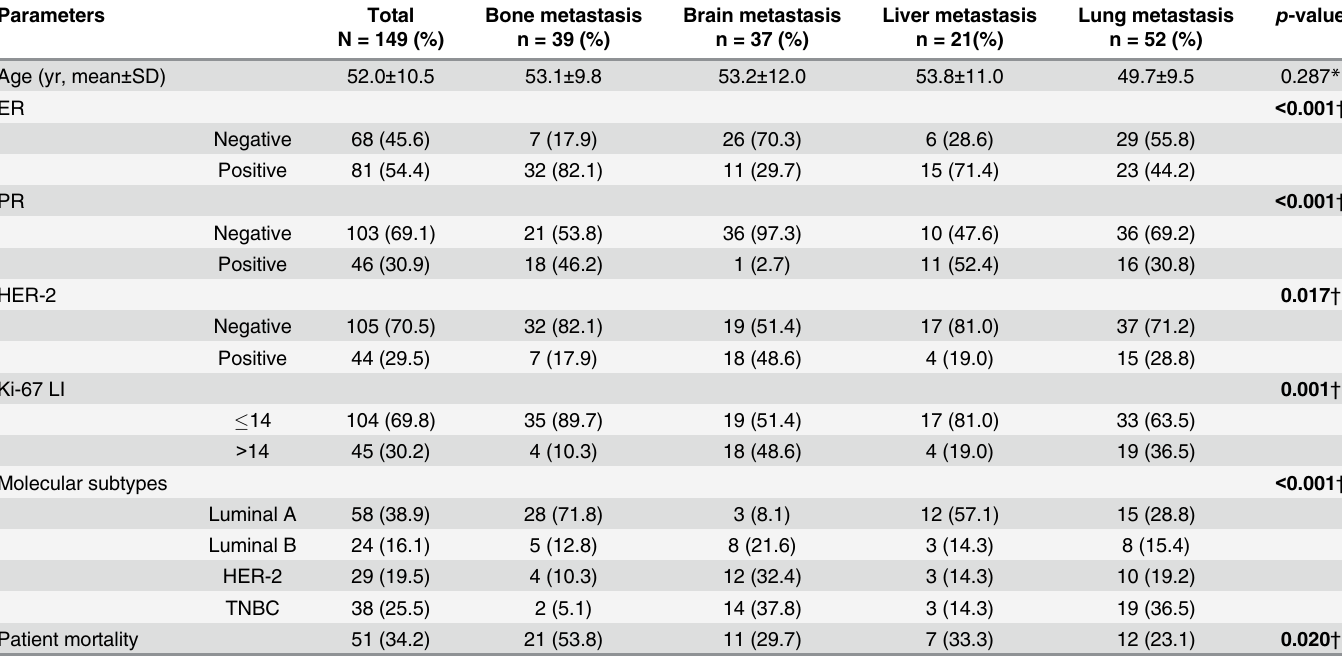
Table 2. Basal clinicopathologic characteristics of patients with breast cancer metastasis according to metastatic site.